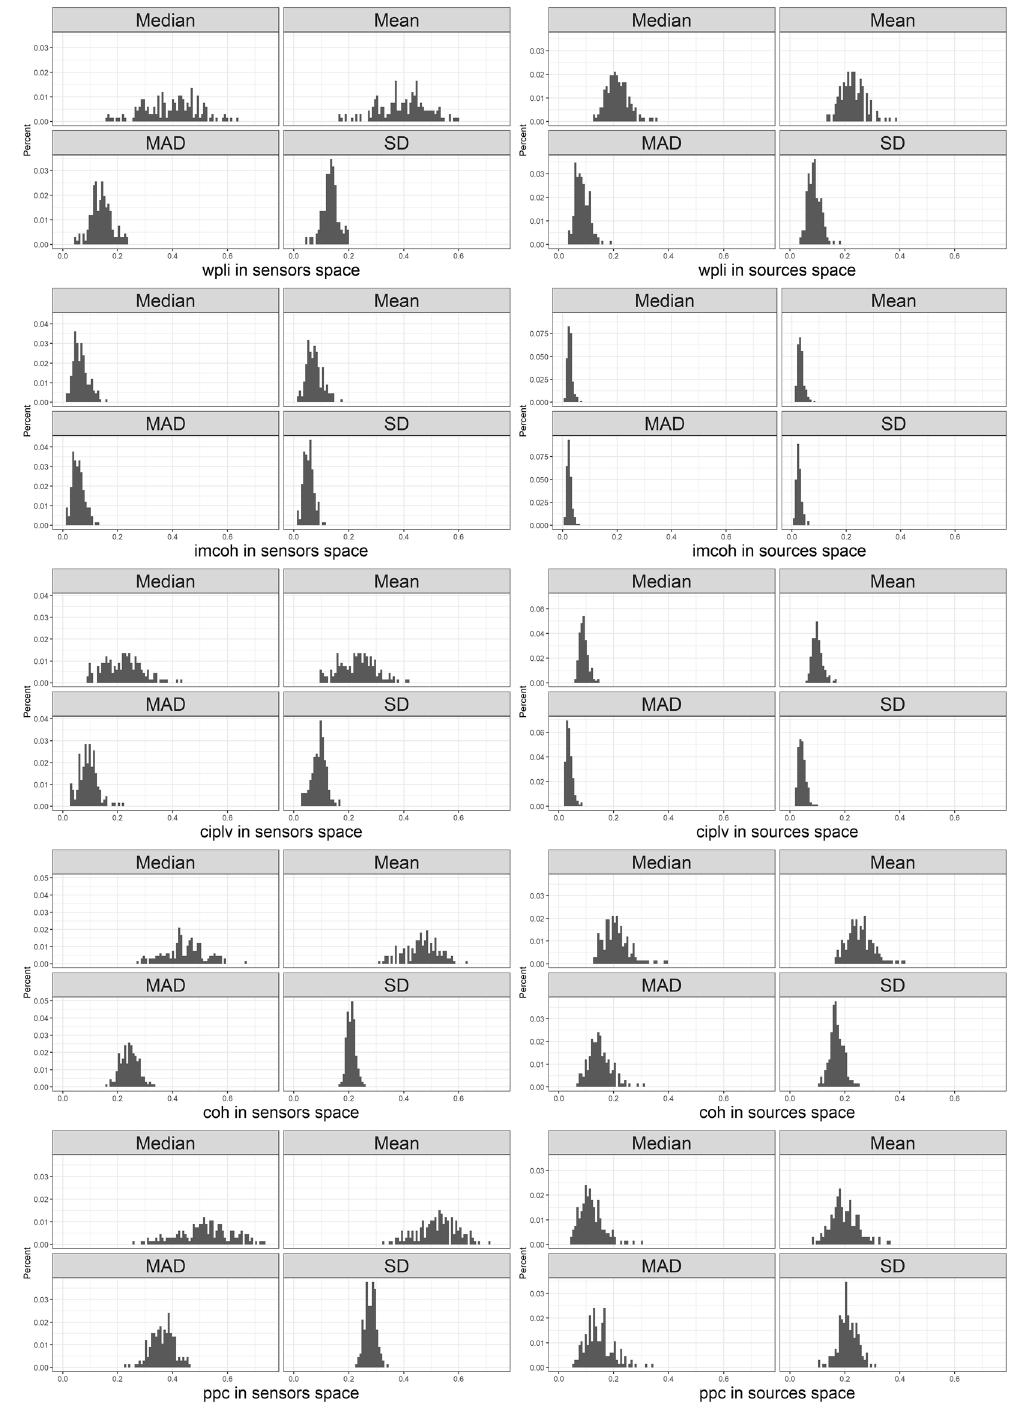
Figure 1. Distribution of descriptives for connectivity measures in sensor and source space. ggplot2 3.3.6 (https:// ggplo t2. tidyv erse. org/) was used to create this